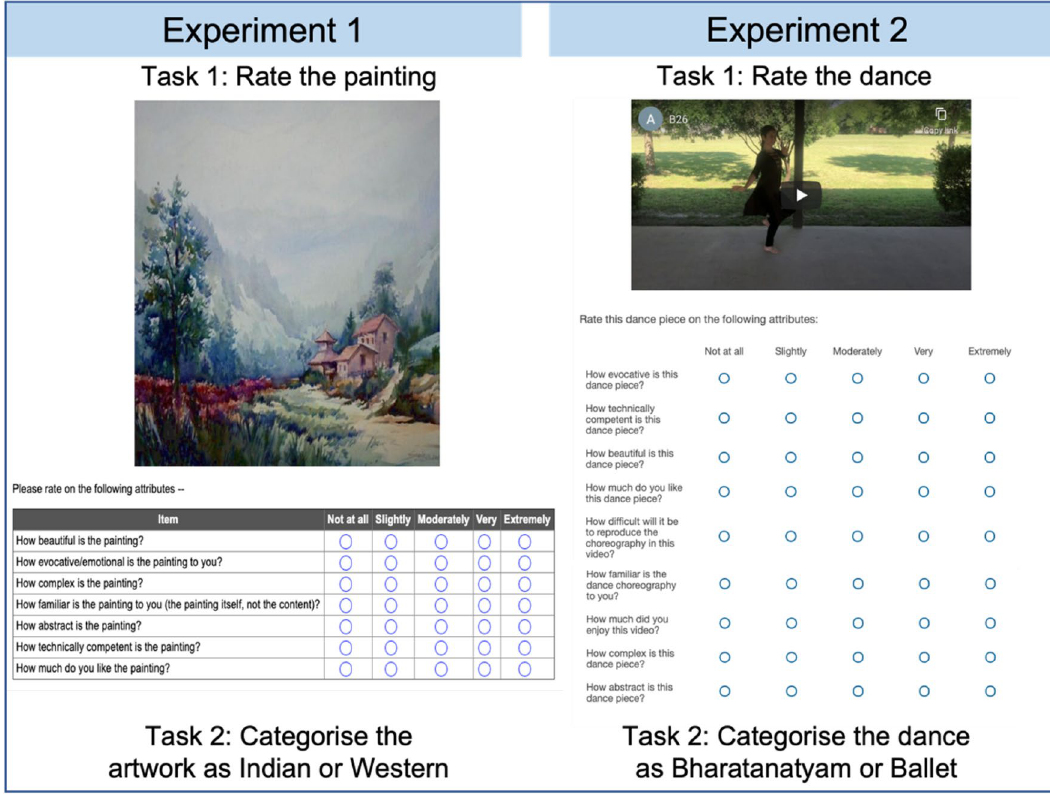
Figure 2. Graphical representation of the rating task and categorisation task for Experiments 1 and